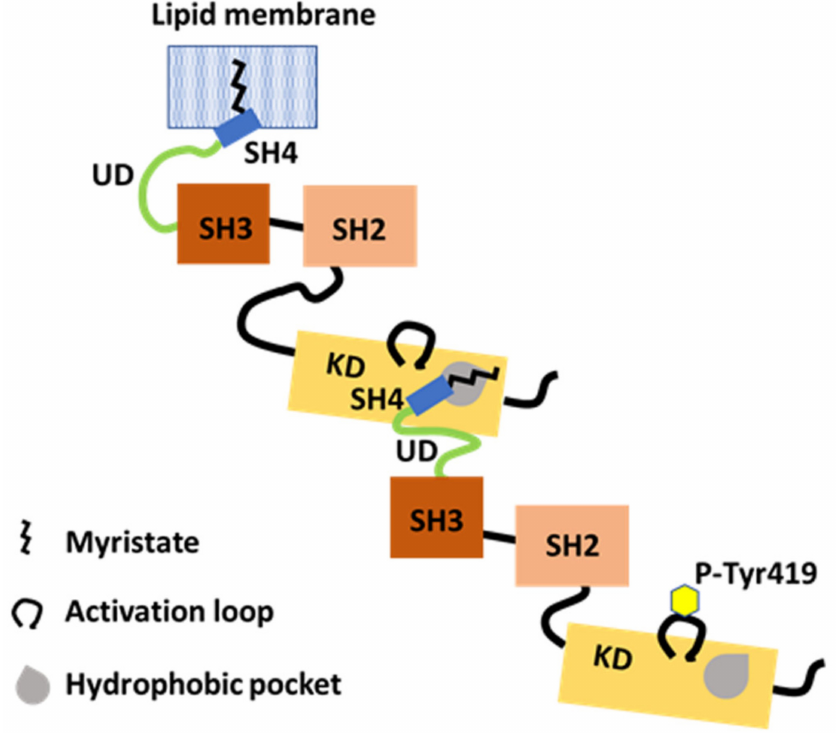
Figure 4. The N-terminal IDR supports dimerization. The myristoylated SH4-UD of one partner with Tyr419 autophosphorylation (P-Tyr419) interacts with the KD of another partner. The N-terminal myristate binds in a hydrophobic pocket in KD in trans. Dimerization and Tyr419 autophosphoryla- tion are dependent on each